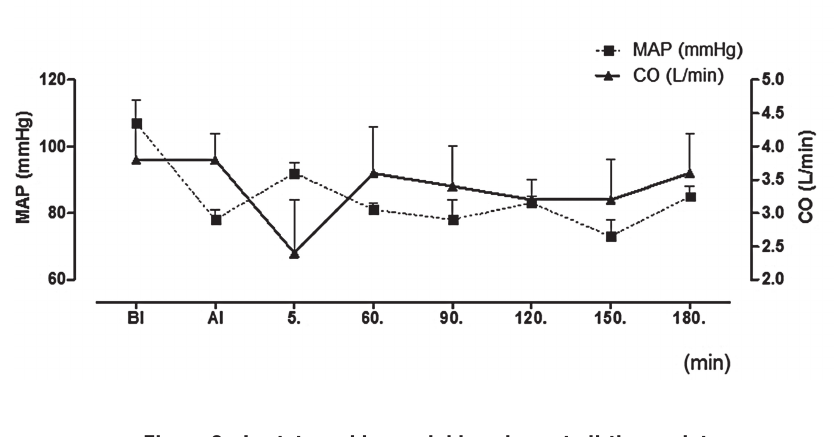
Figure 2 - lactate and hemoglobin values at all-time